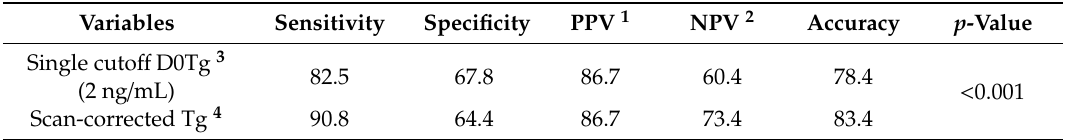
Figure 2. Prediction of the therapeutic response using scan-corrected thyroglobulin (Tg). ( A ) In patients having midline uptake and D0Tg above the cutoff level (5.1 ng/mL), the ratio Tg (D7Tg/D0Tg) is also above the cutoff level (49.2), and the patient showed an excellent response (ER) at the follow-up. ( B ) In patients having midline uptake and D0Tg above the cutoff level (3.7 ng/mL), the ratio Tg is below the cutoff level (5.75 ng/mL), and the patient showed non-ER at the follow-up. ( C ) Patients having midline uptake and D0Tg below the cutoff level (3.1 ng/mL). The patient showed ER at the follow-up. ( D ) Patients having no midline uptake or D0Tg above the cutoff level (3.2 ng/mL). This patient showed non-ER at the follow-up. Table 3. Comparison of the diagnostic performance for response prediction between single cutoff thyroglobulin and scan-corrected thyroglobulin.